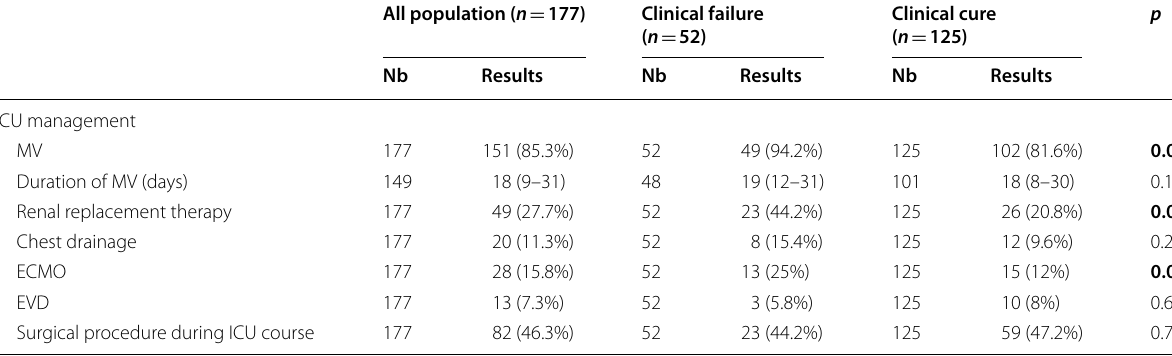
ECMO: Extracorporeal Membrane Oxygenation; EVD: External ventricular Drain; ICU: Intensive Care Unit; MV: mechanical ventilation (invasive); Nb: number of available values for the